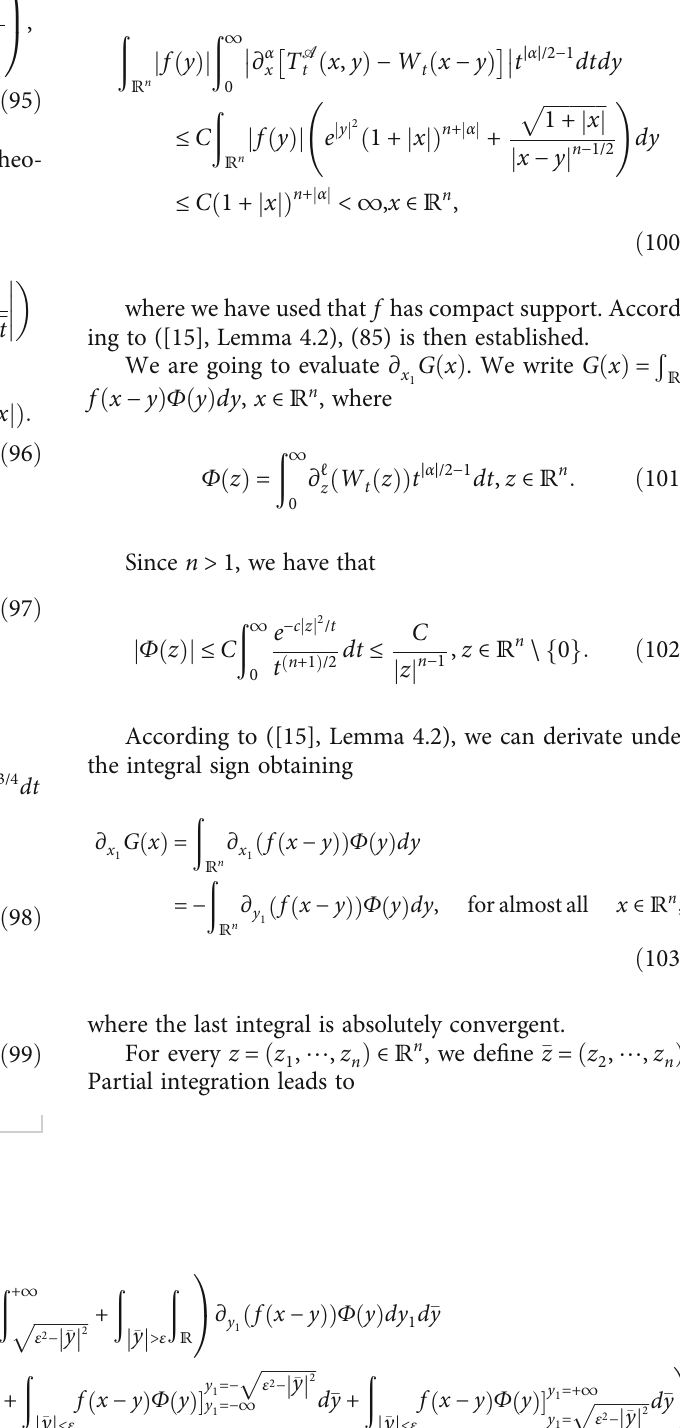
ffiffiffiffiffiffiffiffiffiffiffi p ε 2 − (cid:2) y j j 2